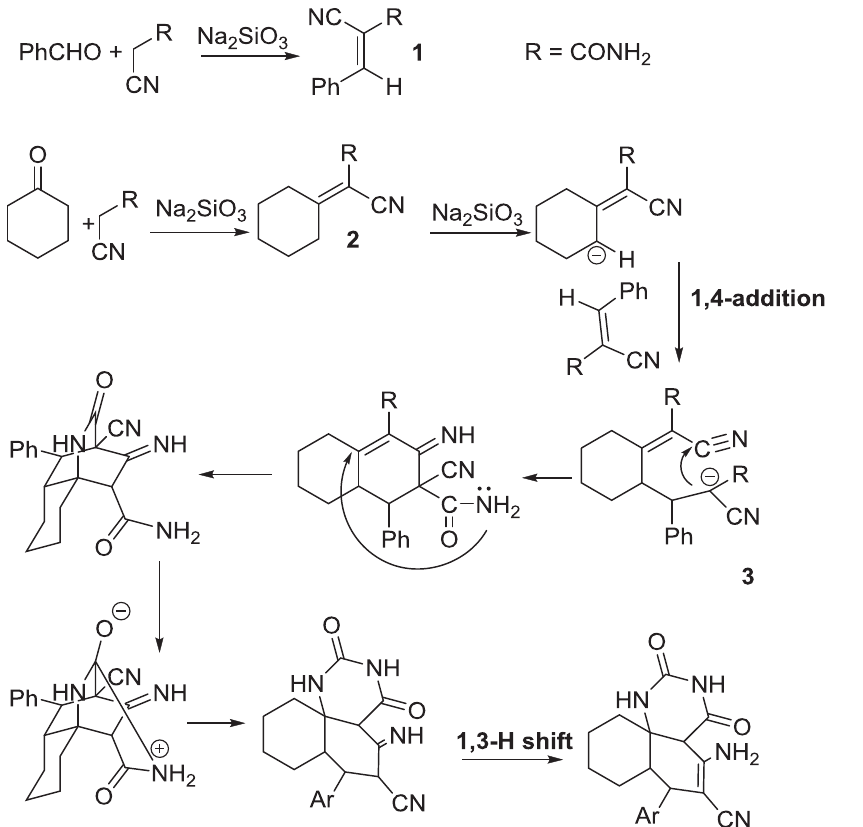
Scheme 2: proposed mechanism for the synthesis of 5-amino-7-aryl-2,4-dioxo-2,3,4,4a,7,7a,8,9,10,11-decahydro-1H-benzo[i]